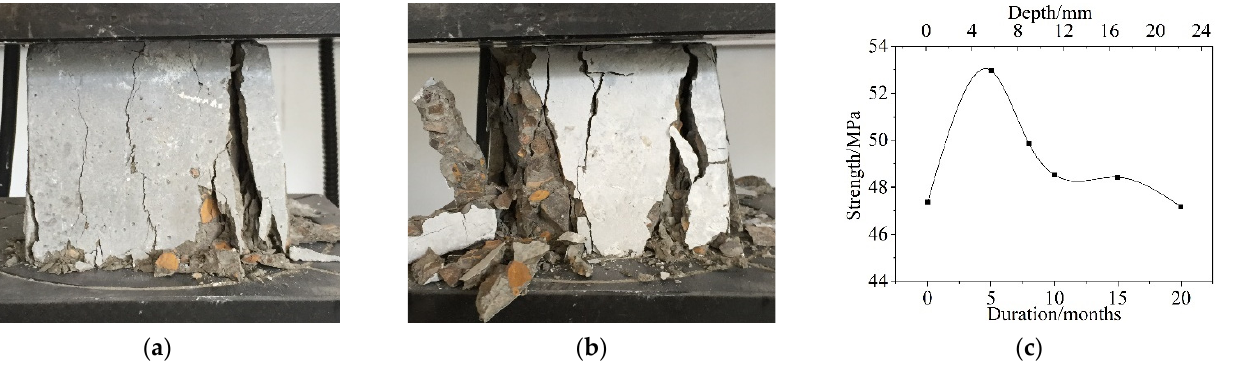
Figure 2. Failure patterns and variation in compressive strength after different dry and wet cycle inspection periods. ( a ) 5 months, ( b ) 10 months, ( c ) Variation in compressive strength.